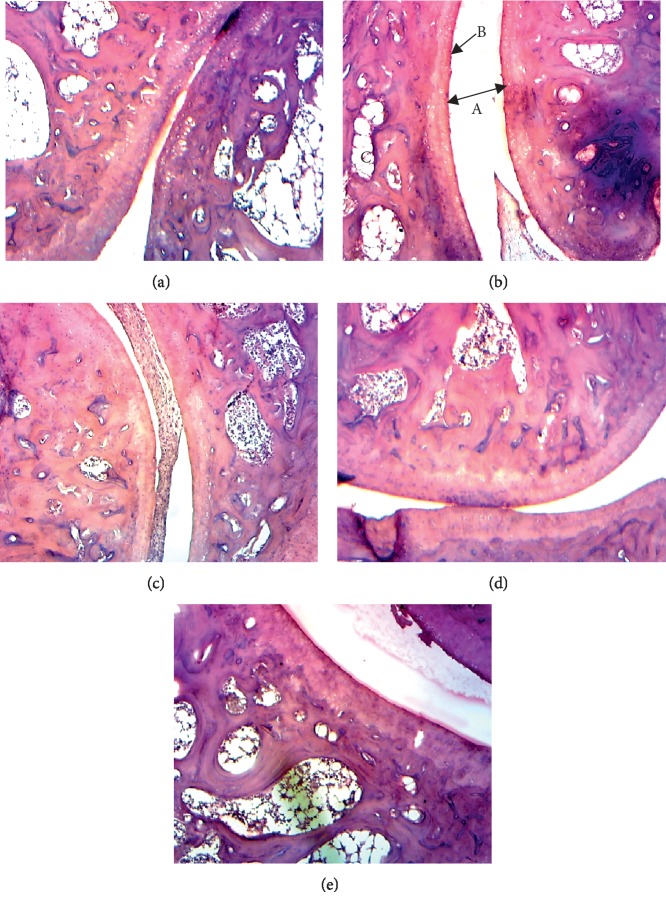
Histopathological analysis of ankle joints stained with H&E. (a) Healthy control showing normal structure with small joint space; (b) Arthritic control showing very large joint space (A), erosion of articular cartilage (B), and bone erosion (C), (c) diclofenac 5 mg/kg treated, (d) aqueous extract (AE) 500 mg/kg treated, and (e) ethanolic extract (EE) 500 mg/kg treated showing a decrease in joint space, erosion of the synovial membrane and a reduction of erosion of articular cartilage.